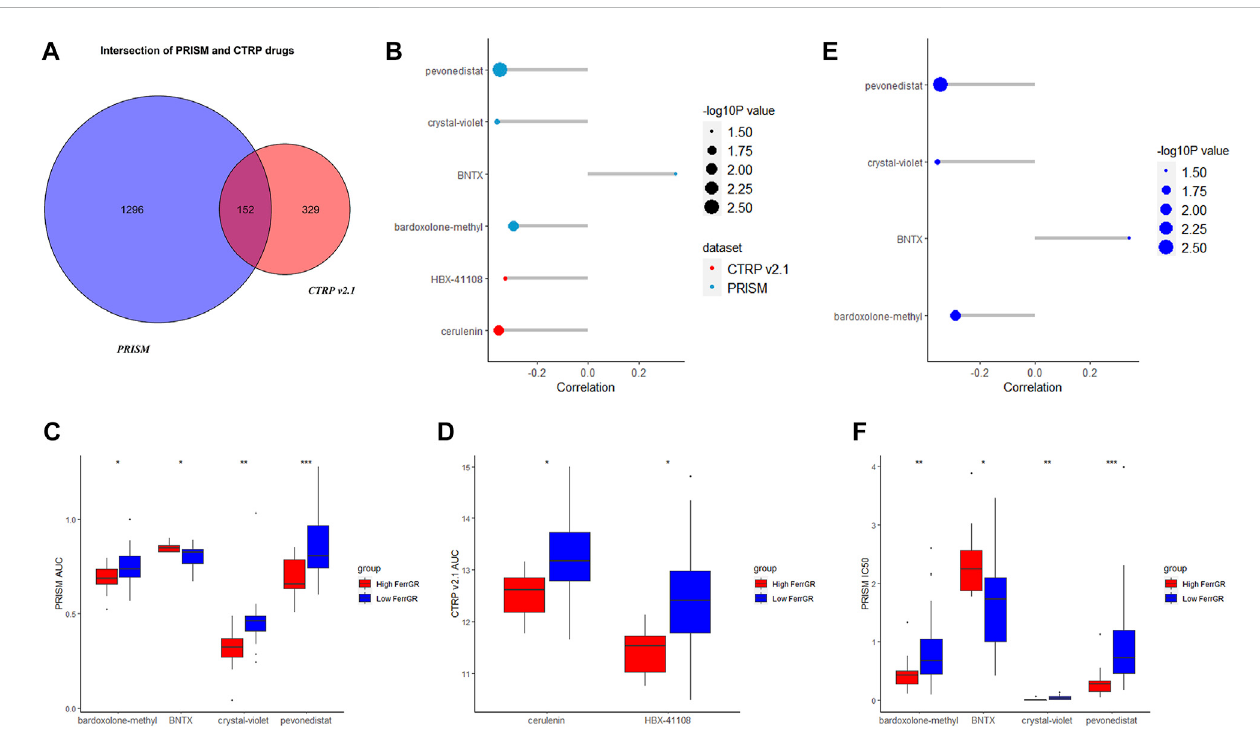
FIGURE 8 Potential targeted drugs prediction on basis of the FerrGR model. (A) The Venn chart showed the number of drugs in the PRISM dataset and CTRP v 2.1 databases. (B) The correlation between the AUC value of potential drugs and the FerrGR score. (C,D) The distribution of the AUC value of each potential drug from (C) RISM datasetand (D) CTRPv2.1databaseaccordingto theFerrGRmodel. (E) The correlationbetweentheIC50 valueofpotentialdrugs andthe FerrGR score. (F) The distribution of the IC50 value of each potential drug on basis of the FerrGR